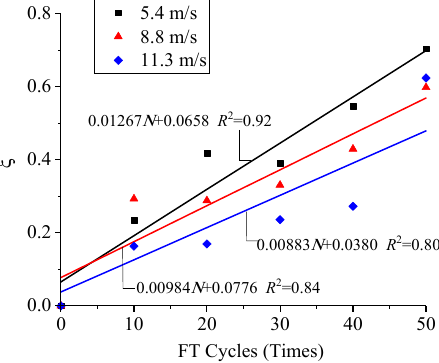
ξ with FT cycles.